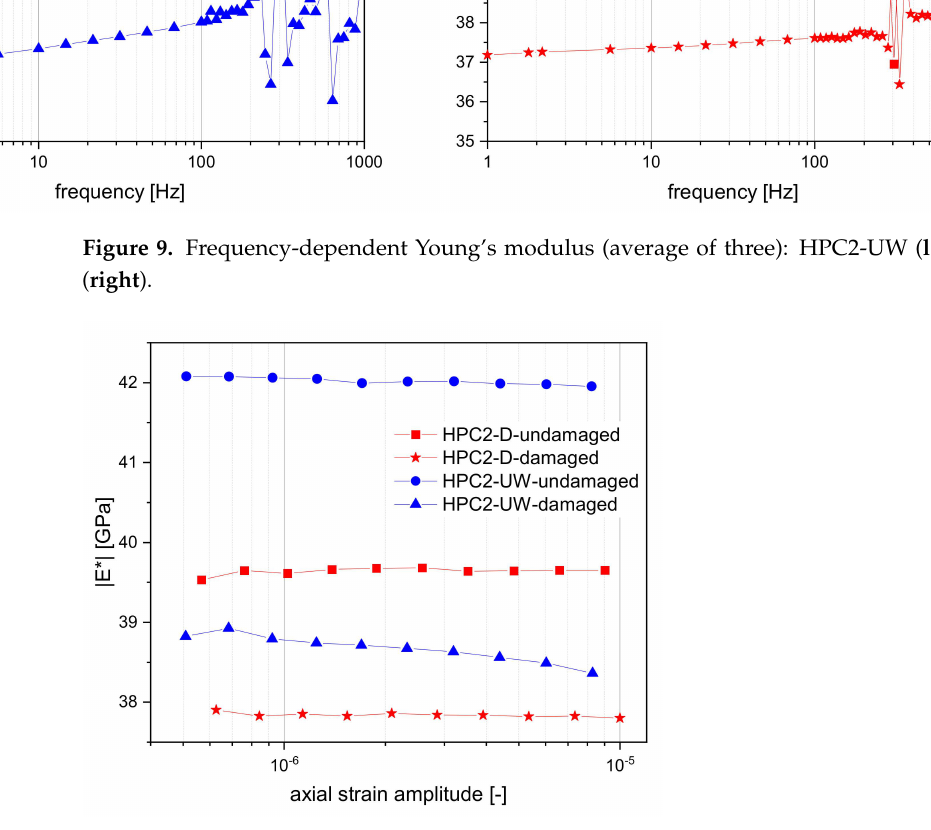
Figure 10. Amplitude-dependent Young’s modulus at 100 Hz (average of three